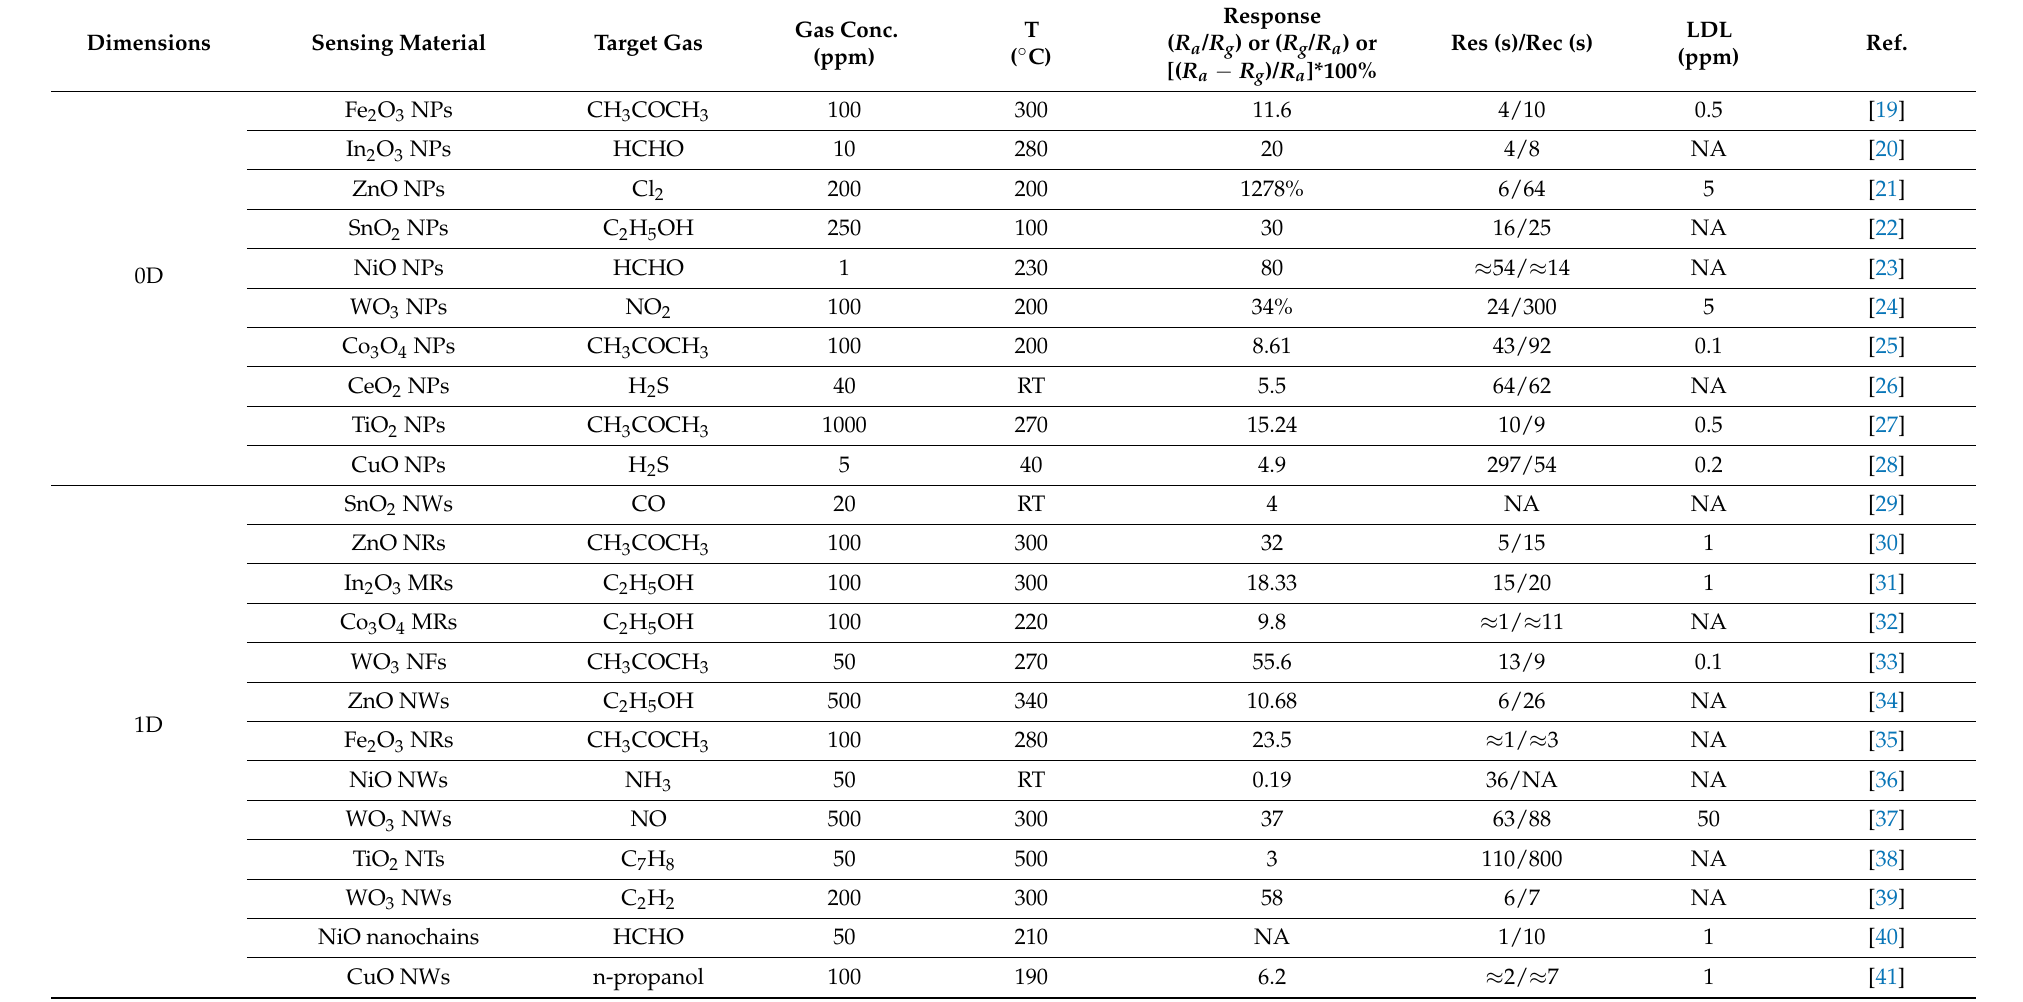
Table 2. A comparison of the most commonly used metal oxides, with different surface morphologies, as chemiresistive gas sensors.